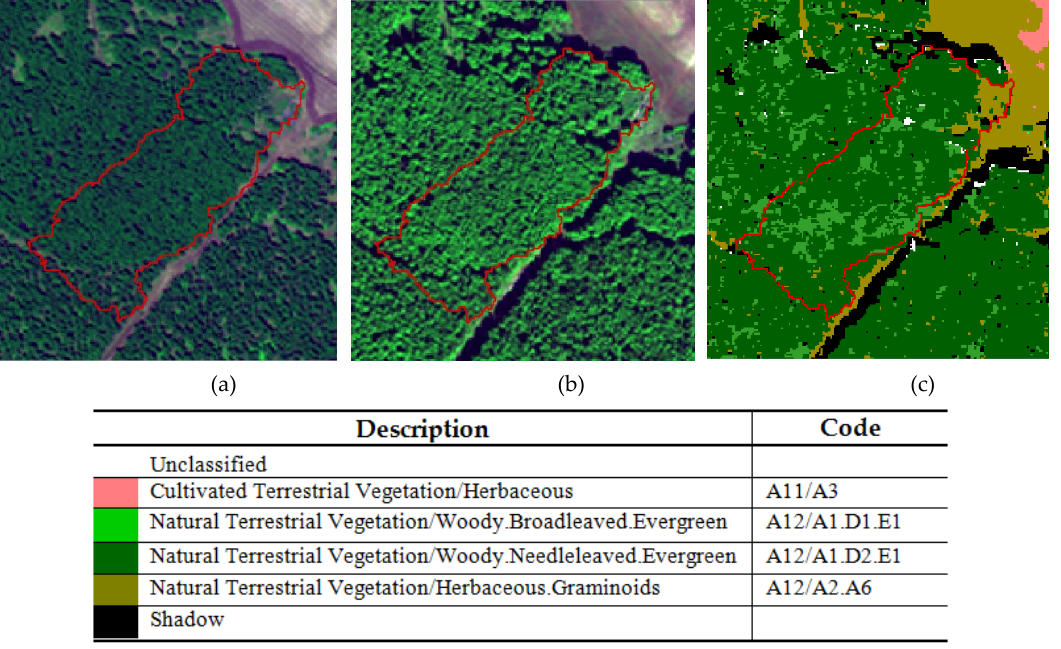
Figure 12. A close-up of an area of Murgia Alta. ( a ) DS image, ( b ) PostPoB image, ( c ) SO map. In the red line the LO considered